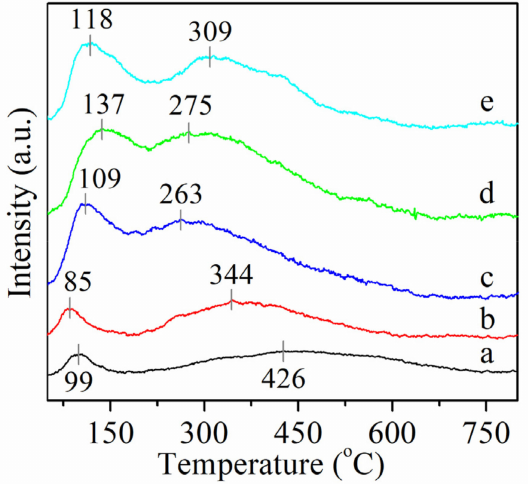
Figure 8. O 2 -TPD (temperature programmed desorption) profiles of the catalysts. (a) Ho 2 O 3 -NP,